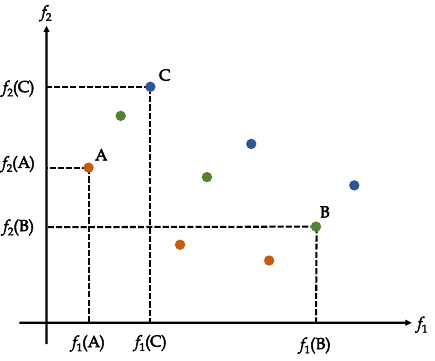
Figure 1. Solutions in a two-dimensional objective